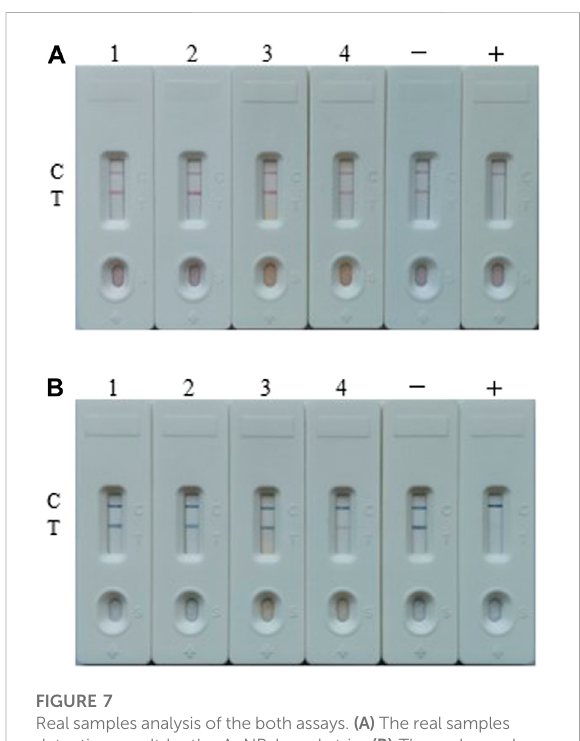
FIGURE 7 Real samples analysis of the both assays. (A) The real samples detection result by the AuNP-based strip. (B) The real samples detection results by the AuNF-based strip test. Sample 1 and 2 were apple juice, while sample 3 and 4 were tomato ketchup. Samples 1 – 4 contain 0.051 ± 0.043, 0.073 ±